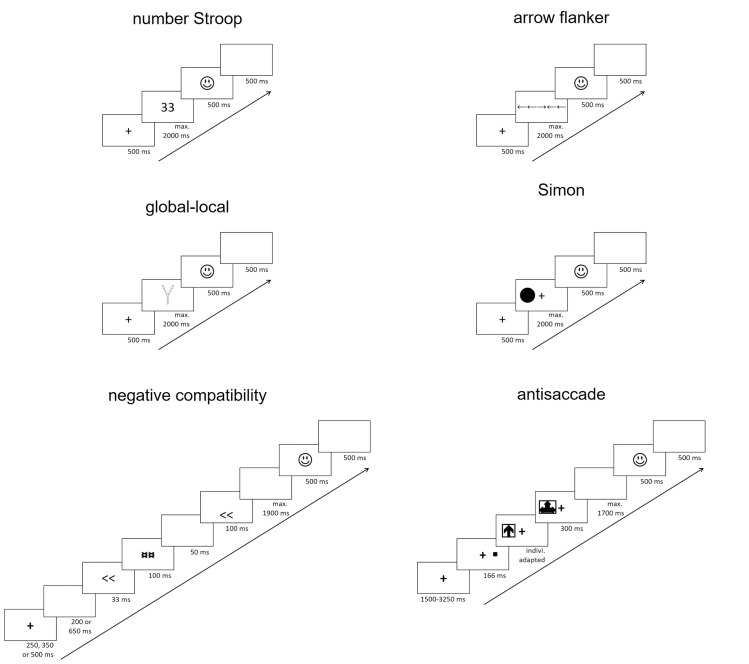
Example of one trial sequence for each inhibition task used in the present study.Indivi. = individually.